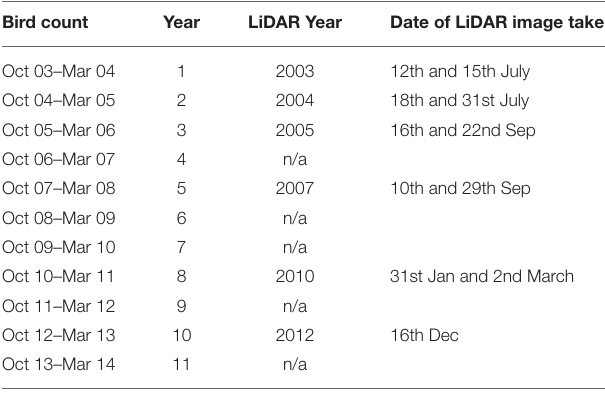
TABLE 2 | Bird count periods with their corresponding light detection and ranging (LiDAR) periods. Bird